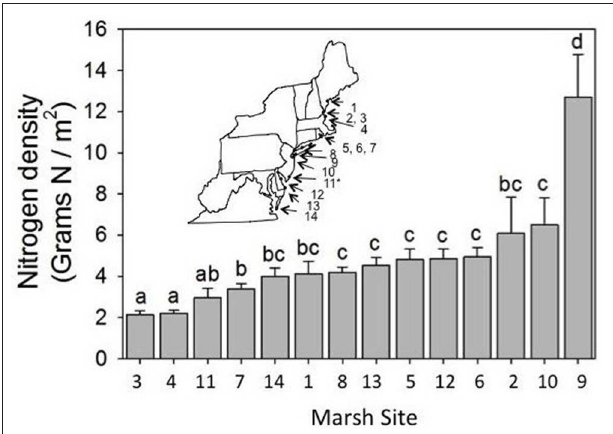
FIGURE 1 | Mean nitrogen density varied across marshes [ F (13, 136) = 12.73, P < 0.0001]. Inset shows approximate locations of the study marshes, which are numbered from north to south. We found no trend in nitrogen density with latitude [ F (1, 14.6) = 2.62, P = 0.15]. Specific information about marsh study locations and sample size can be found in Supplement 1 . Error bars show standard errors of the means. Asterisk denotes site of our plot-level manipulations in NJ, and letters indicate significant